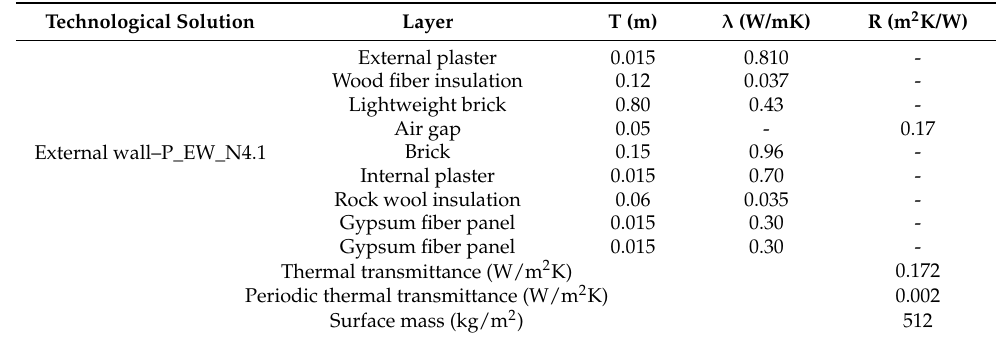
Table A10. Possible upgrade measure of external wall stratigraphy (P_EW_N4.1) with ETICS techno- logical solution as external finishing and insulation material made of wood